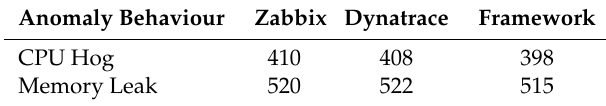
Table 10. Anomaly detection and identification latency